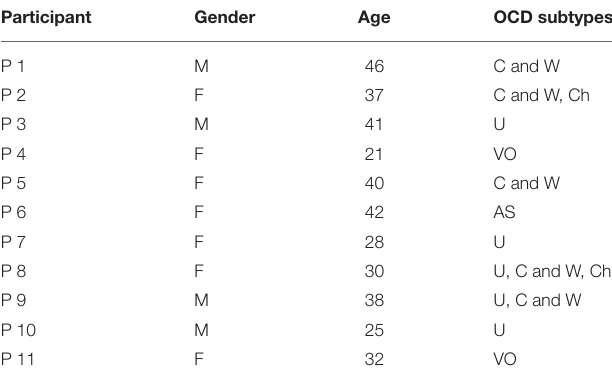
TABLE 1 | Clinical summary of